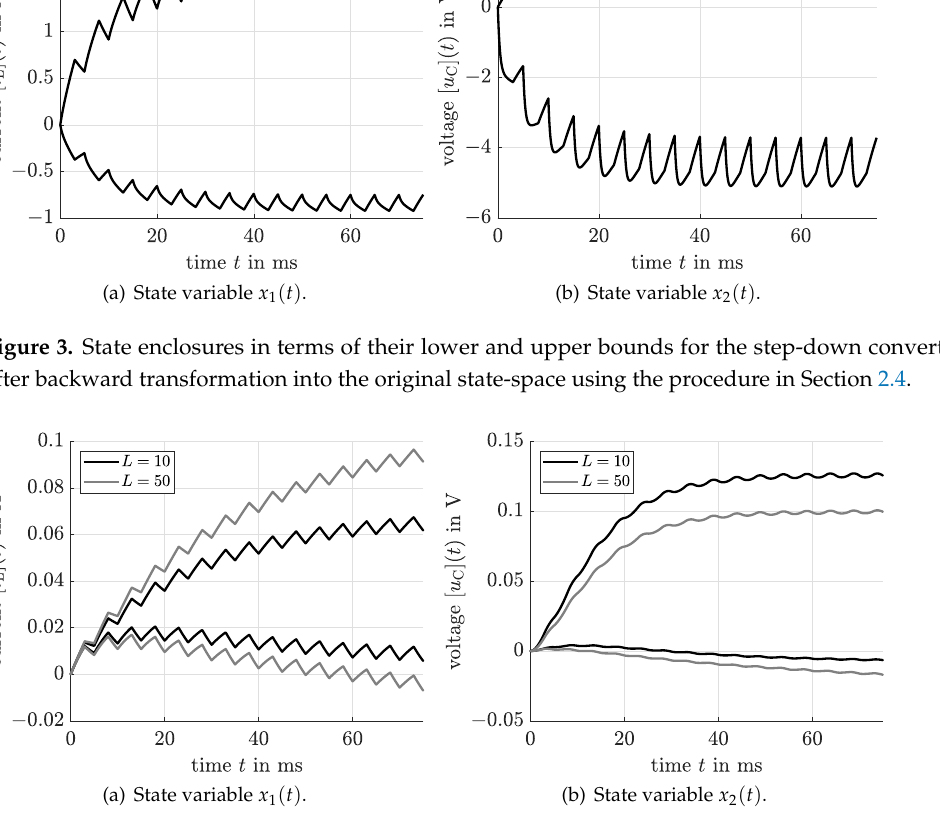
Figure 4. State enclosures for the step-down converter using the novel procedure according to Section 3 in combination with the real-valued transformation approach of Section 2.3.